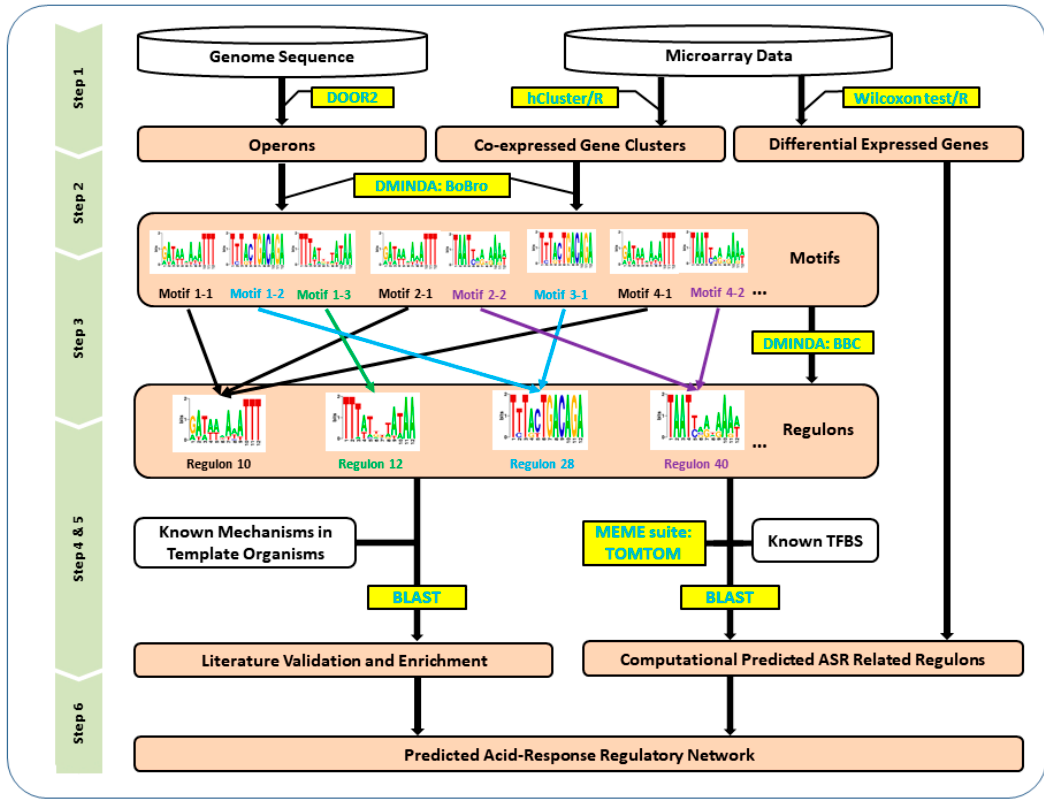
Figure 1. The flowchart of constructing the global acid stress response (ASR) transcriptional network in MG1363. Step 1: microarray data was used to generate co-expressed gene clusters and differentially expressed genes (DEGs), and the MG1363 genome sequence was used to find operons. Step 2: a motif finding progress was carried out to identify all statistically significant motifs in each of the co-expression gene modules (CEMs). Step 3: a regulon finding procedure was designed to identify all the possible regulon candidates encoded in the genome based on motif comparison and clustering. Step 4: the motifs of each of these regulons were compared to known transcription factor binding sites (TFBSs), and differential gene expression (DGE) analysis between low pH conditions and normal conditions was used to figure out the ASR-related regulons. Step 5: regulon validation based on literature information verified the significant putative regulons and expanded the results to some insufficiently significant regulons. Step 6: the ASR-related gene regulatory network (GRN) in MG1363 was predicted and described with eight regulons, nine functional modules, and 33 genes. The combination of the above information forms a genome-scale regulatory network constructed for ASR. Abbreviations: DOOR2, Database of Prokaryotic Operons 2.0; BBC, BoBro-based motif comparison; BLAST, basic local alignment search tool; BoBro, Bottleneck